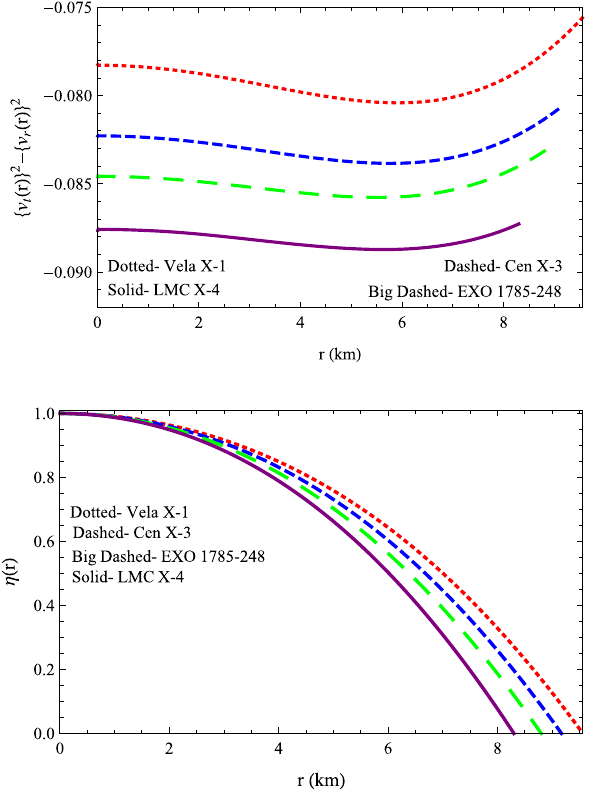
Fig. 10 Stability factor (above) and η( r ) (below) vs the radial coordi- nate r corresponding to numerical values of constants given in Table 2 for four well-known compact stars